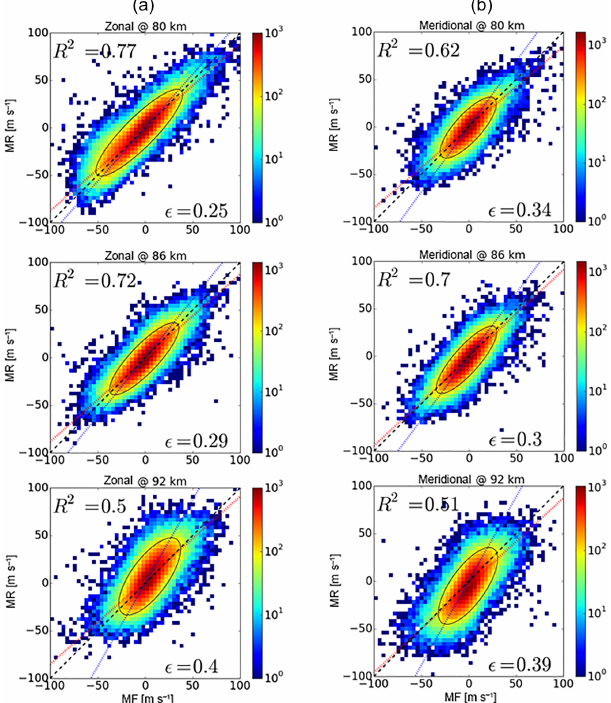
Figure 8. Scatter plots of MR versus MF zonal (a) and merid- ional (b) wind component for 80, 86, and 92km. The contour shows the number of wind values for 2004–2014. The black dashed line shows the line of equality. The red dashed line shows the least ab- solute deviation linear fit with MR as an independent variable, and the blue line is with MF as an independent variable. The ellipse within the contour plot is a criteria for the correlation of the two systems; (cid:15) is calculated by the width divided by the length of the